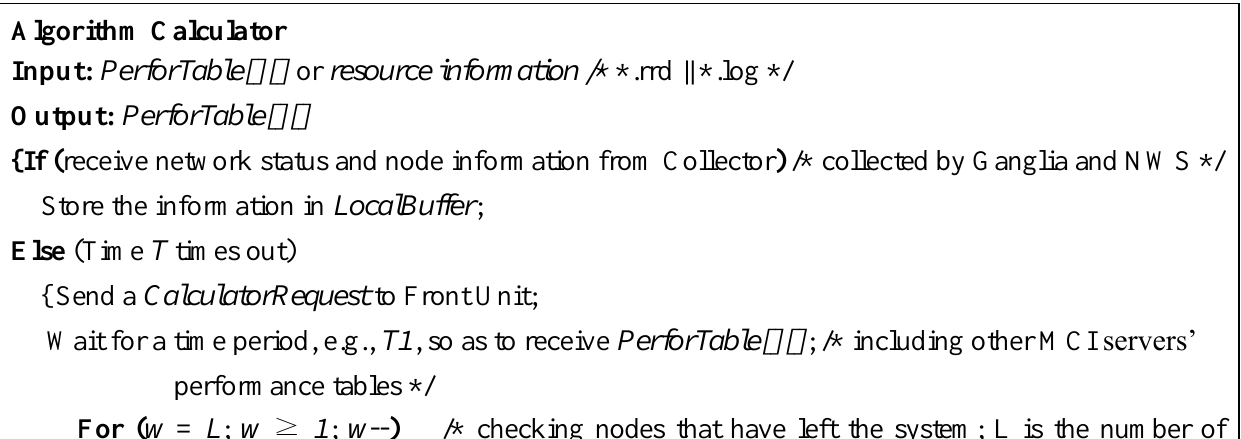
Figure 6. The algorithm performed by Calculator